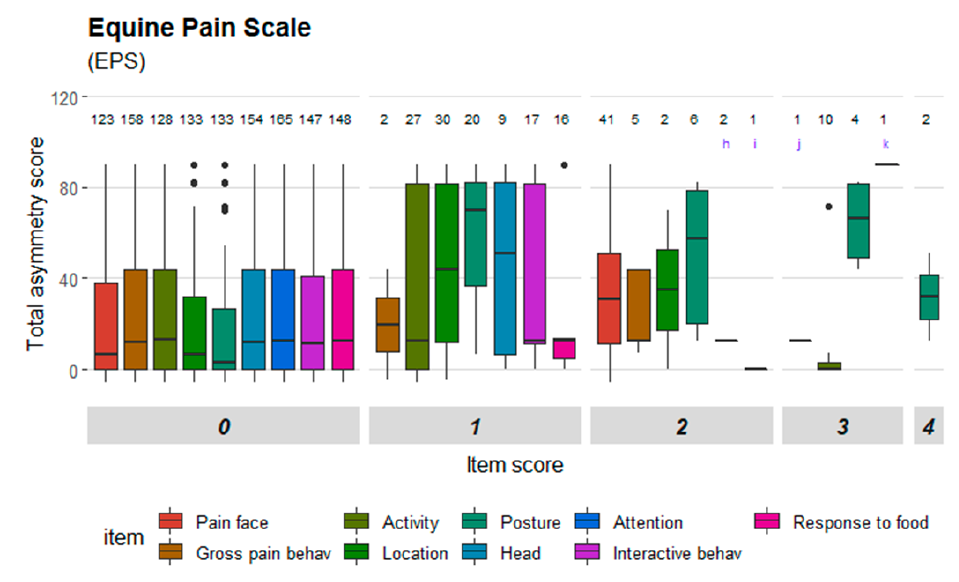
Figure 3. Distribution of item scores for Equine Pain Scale (EPS). Total asymmetry score is presented on the y-axis. Scale items are presented on the x-axis and divided into the item scores given (ranging from 0 to 4). Letters in the diagram: h—head position, i—interactive behavior, j—pain face, k— response to food.